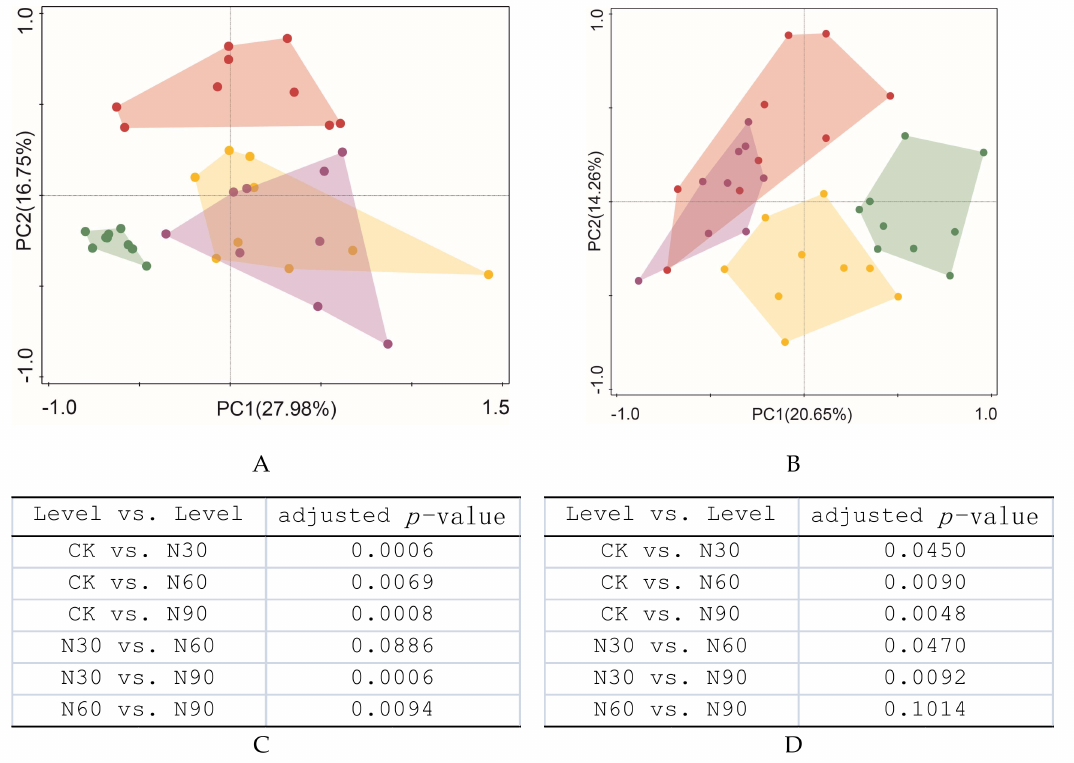
Figure 2. Principal coordinates analysis (PCoA) based on the weighted calculated method and Bray-Curtis distances showing the changes in soil bacterial ( A ) and fungal ( B ) compositions (based on operational taxonomic unit (out) datasets of genus) in the CK, N30, N60 and N90 levels. Pairwise comparisons for factor sort of soil bacterial ( C ) and fungal ( D ) compositions showing the significance of di ff erence between each pair of treatments based on the Benjamini–Hochberg adjusted p -value method for multiple comparisons. The transparent polygon represents the distribution range of sampling plots. Green, yellow, purple and red circles represent the soil samples collected from CK, N30, N60 and N90 plots, respectively, using the data microbial profile at the genus level. To identify the results of PCoA, the tables underneath each PCoA report pairwise comparisons for factor sorted among CK, N30, N60 and N90 levels. PCoA indicated that the changes in the soil bacterial and fungal compositions and structure may have been associated with the changes in simulated nitrogen deposition (SND) in the moso bamboo